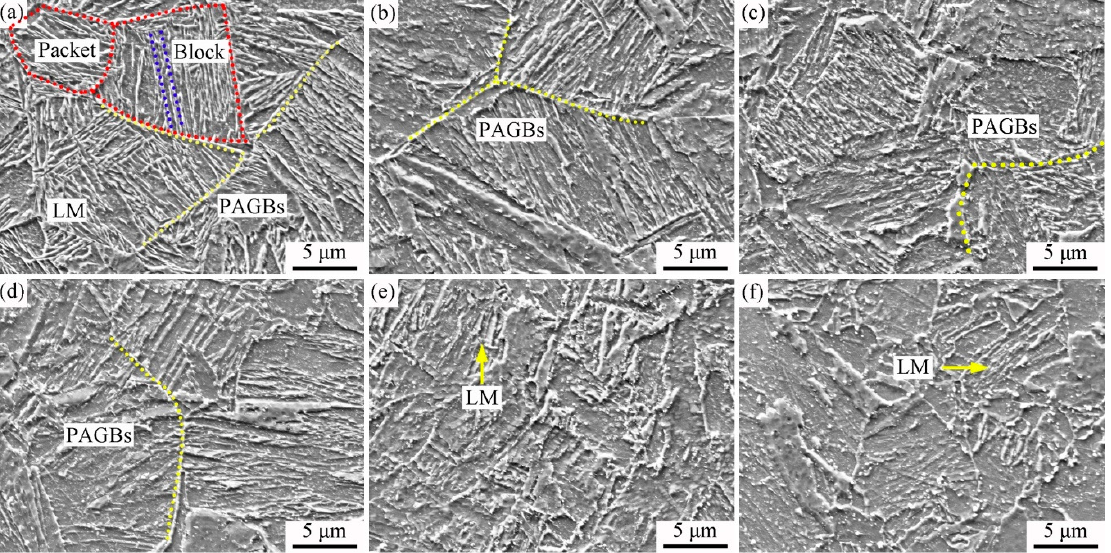
Figure 4. SEM micrographs of the specimens after different heat treatments. ( a ) WQ, ( b ) QT400, ( c ) QT450, ( d ) QT500, ( e ) QT550, ( f ) QT600.